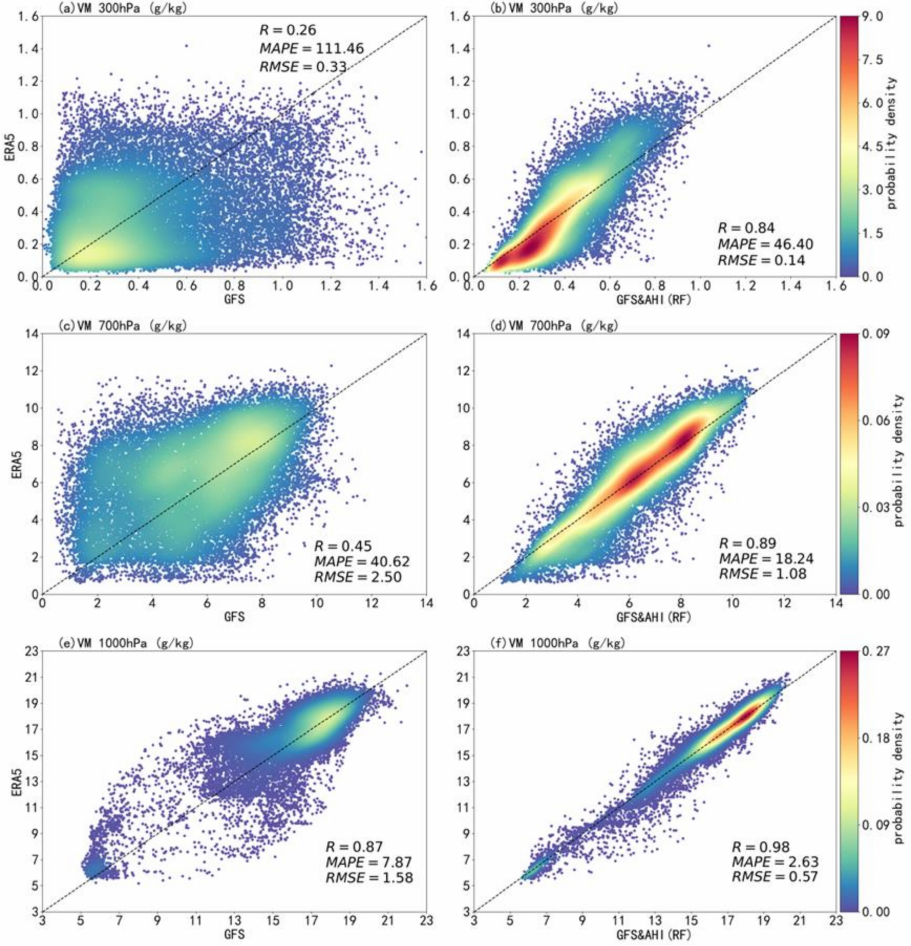
Figure 2. The probability density of the VM derived from the GFS forecasts ( a , c , e ) and the retrievals the from RF-based algorithm ( b , d , f ) against the ERA5 at 300 hPa ( upper ), 700 hPa ( middle ), and 1000 hPa ( bottom ),